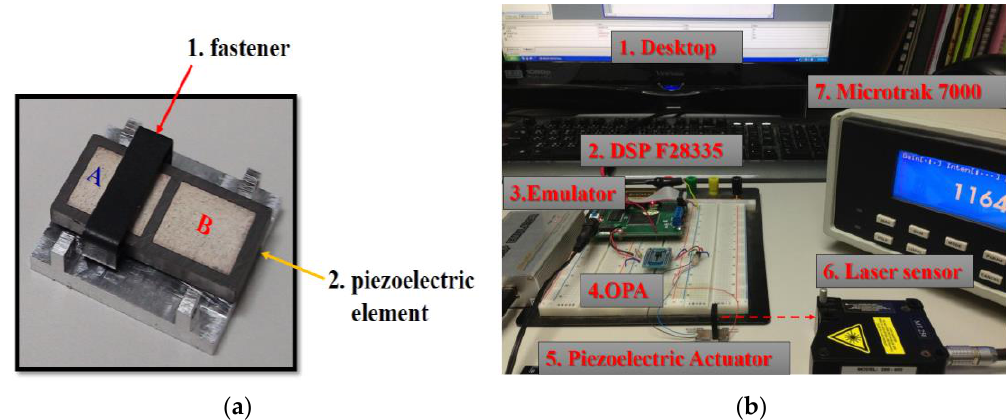
Figure 14. Experimental installation of the proposed micro-positioning design: ( a ) a piezoelectric-based actuator and ( b ) the overall micro-positioning system with a position measuring system, a piezoelectric-based actuator, and the proposed adaptive fuzzy robust control law carried out in the desktop.